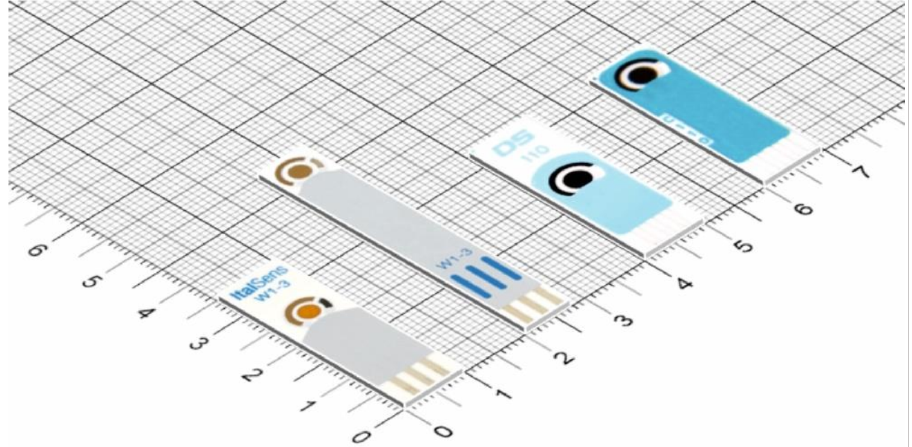
Figure 3. Some examples of commercially available screen-printed electrodes (from different man- ufacturers: https://www.dropsens.com/en/screen_printed_electrodes_pag.html; https://www. palmsens.com/products/sensors/screen-printed-electrodes/, accessed 10 September